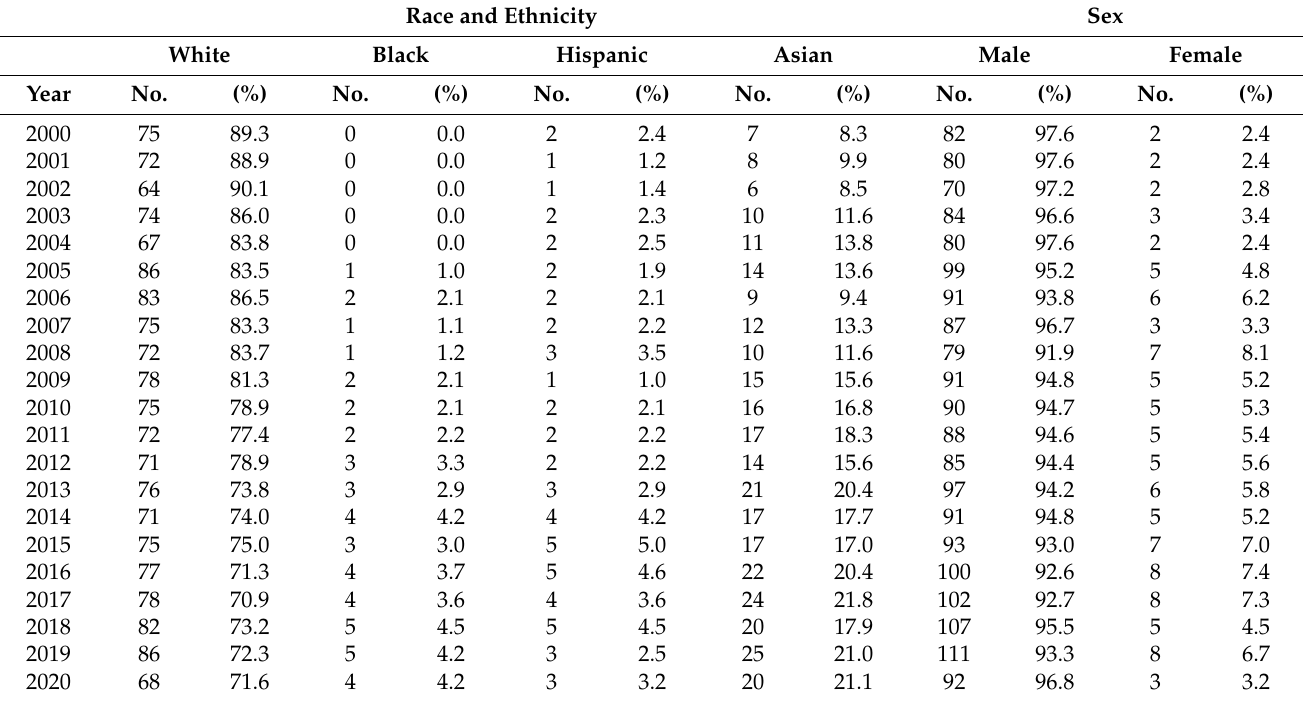
Table 2. Composition of pediatric heart transplantation (HTx) surgeon workforce from 2000–2020. The surgeons listed performed at least one HTx in the indicated